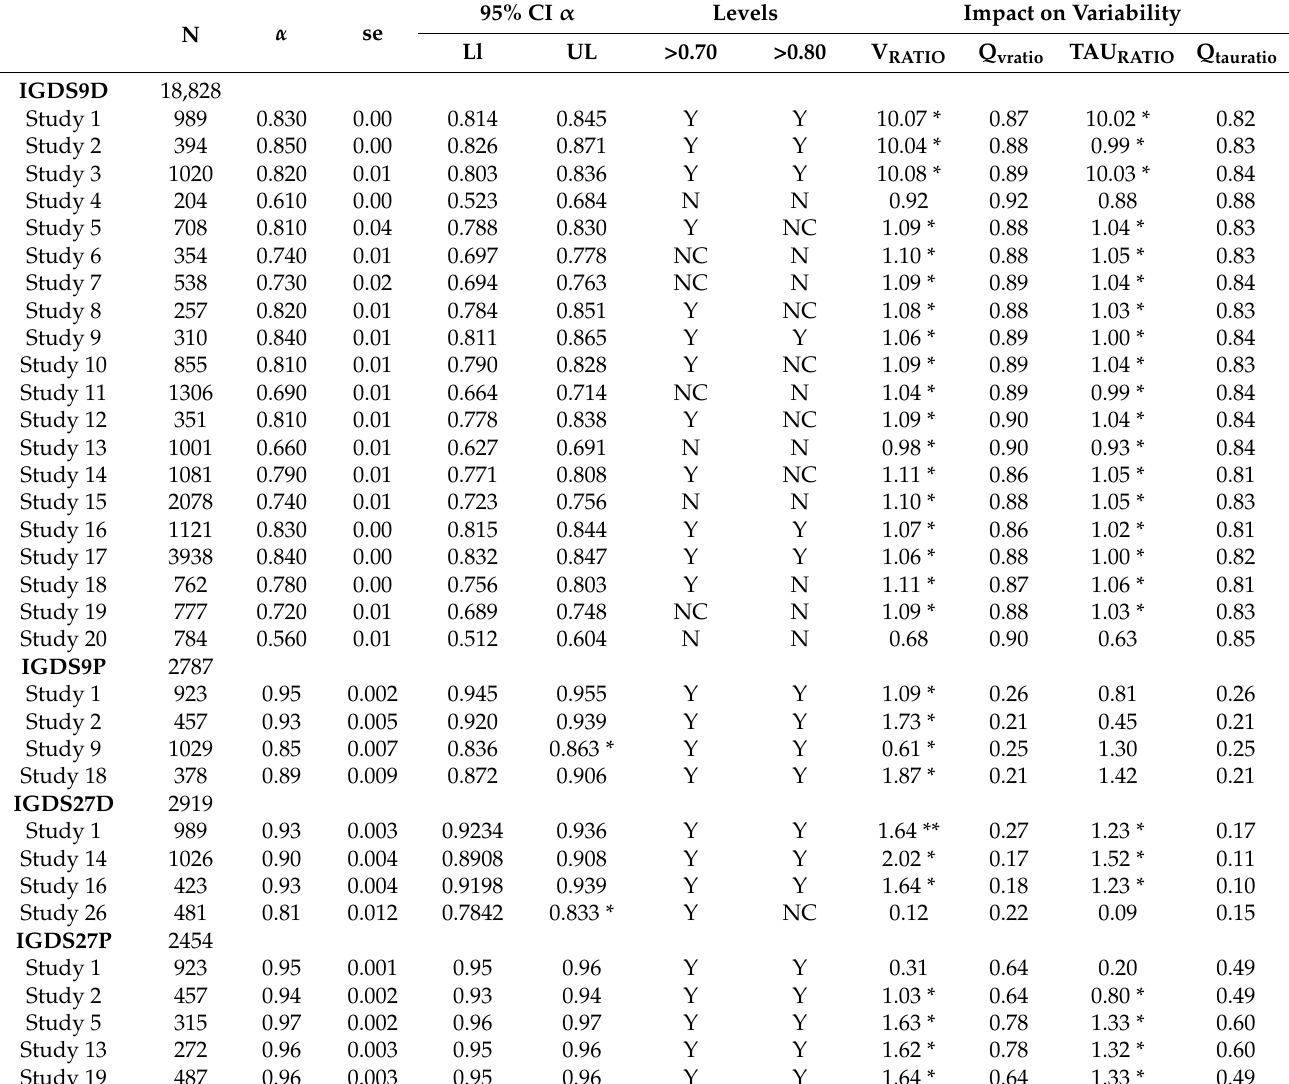
Table 1. Characteristics of the reliability levels of the articles included in the